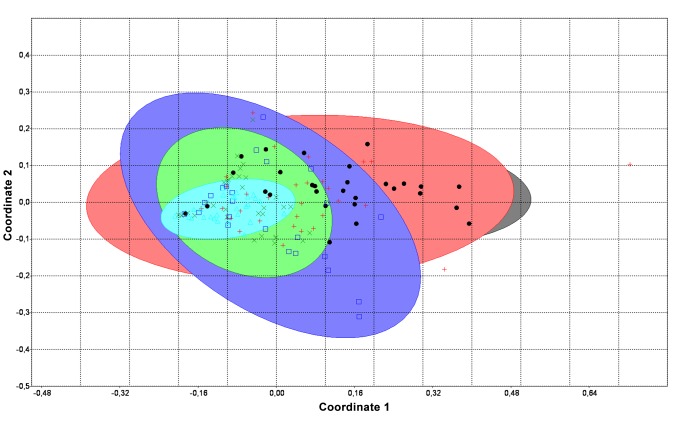
Two-dimensional plot of the Principal Coordinate Analysis (PCoA).The figures shows the clustering of of OxS data (DC, ROS-TAC score and 8-isoprostanes) and illustrating high similarity of both severe inflammation groups.Black dot, Group I; red cross, Group II, violet square, Group III; green cross, Group IV; blue triangle, Group V.